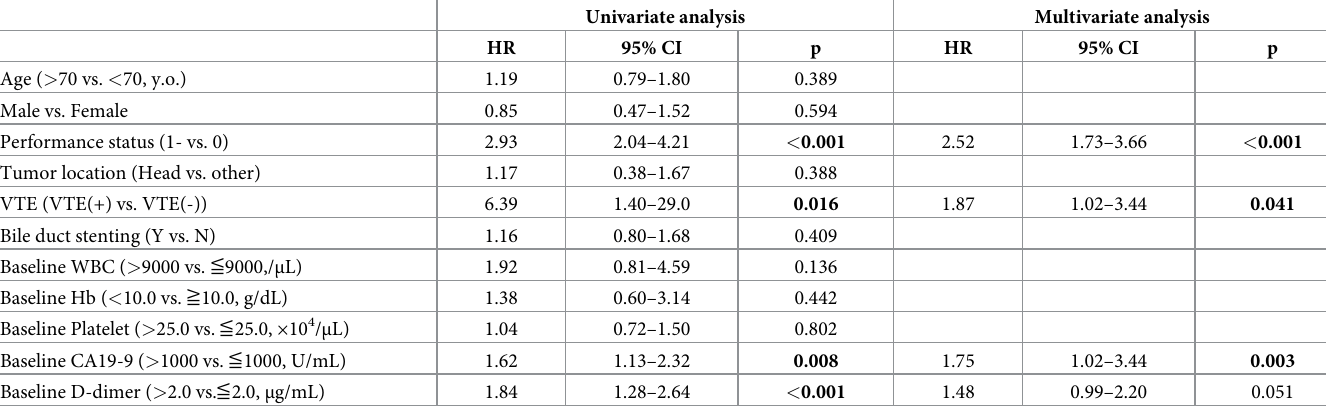
Table 5. Univariate and multivariate analyses of